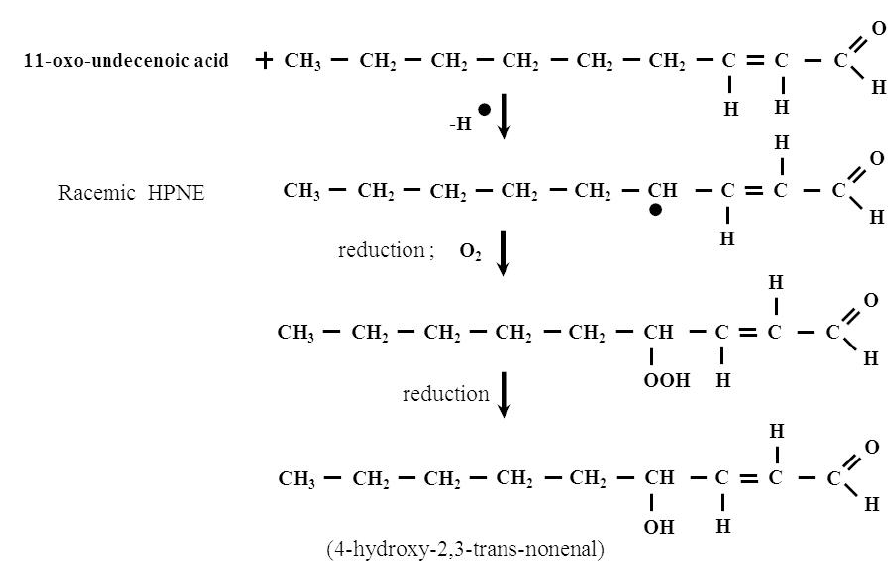
Figure 2. The formation of HNE in the arachidonic acid peroxidation process. 2-Nonenal is one of the intermediates of this process. It is known that the odor of this compounds is perceived as orris, fat and cucumber and it has been associated with human body odor alterations during aging [16]. The process described above takes place in a non-enzymatic manner. Some authors also describe the production of HNE and other aldehydes by enzyme-catalyzed lipid pe- roxidation [17]. Additionally, ω -6 PUFAs, such as linoleic and arachidonic acid are sub- strates for the production of HNE by an enzymatic process. The main enzymes involved in this process include 15-lipoxygenases (15-LOX): 15-LOX-1 and 15-LOX-2, which, unlike other LOXs, can act not only on free fatty acids released from phospholipids under the influence of phospholipases but also on the whole lipid molecules in cell membranes. The 15-LOX-1 is expressed in reticulocytes, eosinophils, and macrophages. The 15-LOX-2 is expressed in the skin, cornea, prostate, lung, and esophagus [18,19]. The main precursors